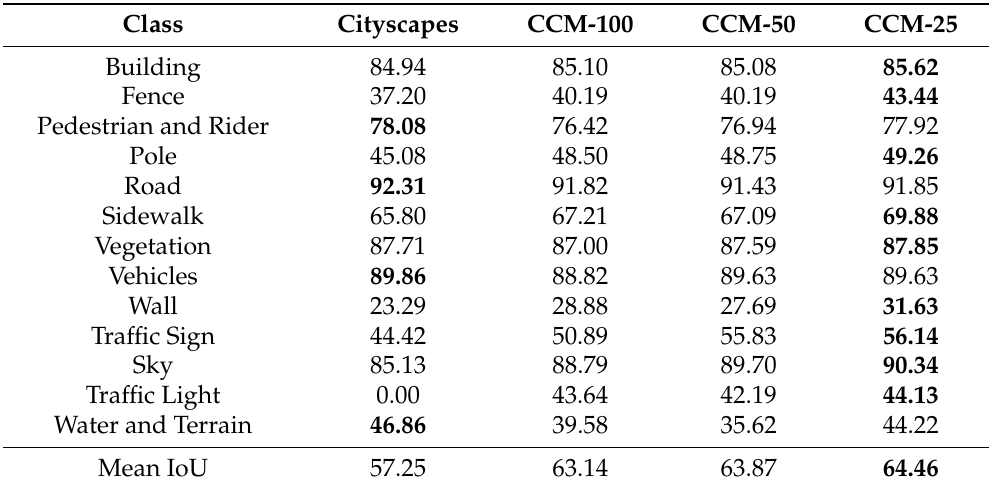
Table 6. Semantic segmentation (IoU) with Xception on Cityscapes and CCM